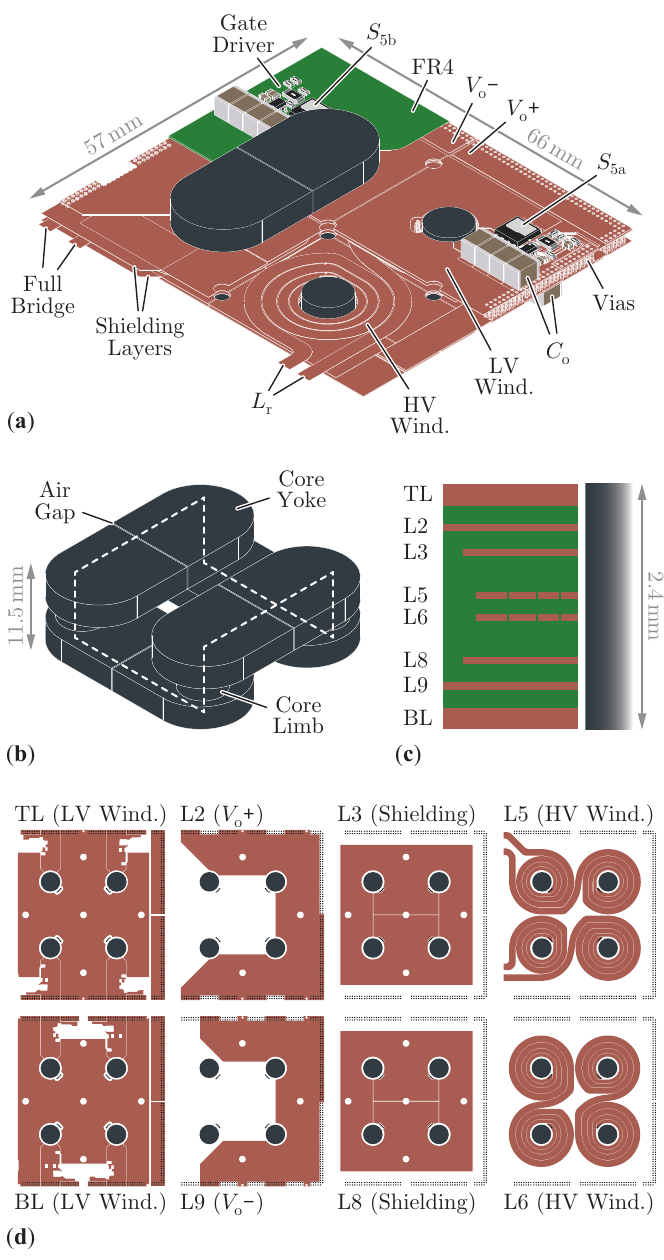
Figure 6. ( a ) The 3-D view of the snake-core matrix transformer with cutaway view of the PCB- integrated windings. The secondary-side semiconductors and output capacitors are placed directly above the low-voltage windings for low termination losses and minimization of commutation loops. ( b ) Snake core with the single path for magnetic flux highlighted with white dashed lines. ( c ) PCB layer stackup from the top (TL) to bottom layer (BL), with copper and isolation thicknesses proportional to the final design. ( d ) Layer-by-layer copper of the 10-layer layout, with layers L4/L7 empty to reduce parasitic